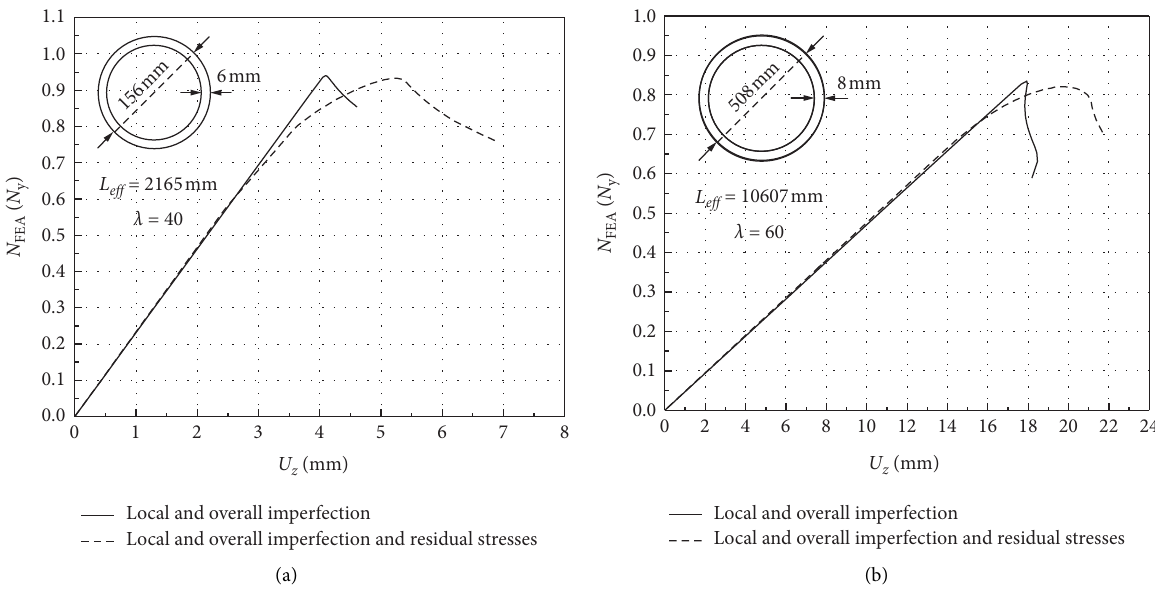
Figure 10: Comparison of load-axial deformation curve whether considering residual stresses. (a) D159 × 6 ( λ � 40). (b) D508 × 8 ( λ � 60).